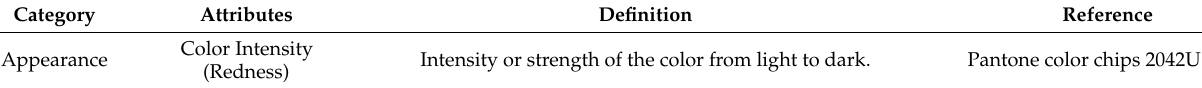
Table 2. Sensory categories and attributes used to describe color, flavor and texture of red leaf lettuce.